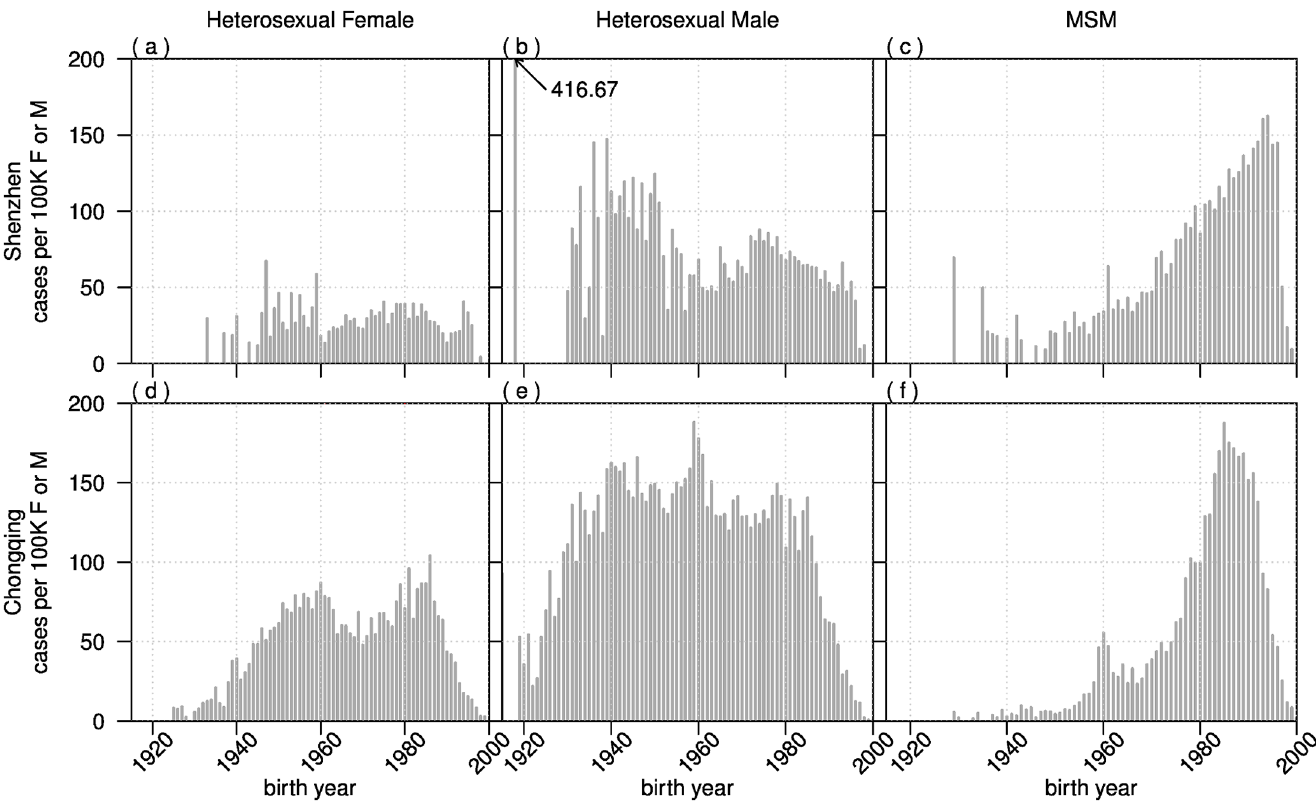
Fig 5. Comparison of number of cases per 100,000 males or females by age at diagnosis distribution by birth year and routes of transmission in Chongqing and Shenzhen. We used the 2010 census for the population’s age profile.